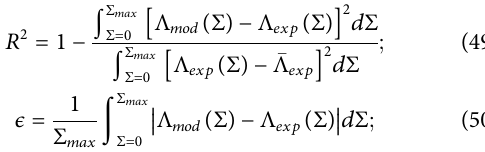
Frontiers in Bioengineering and Biotechnology |